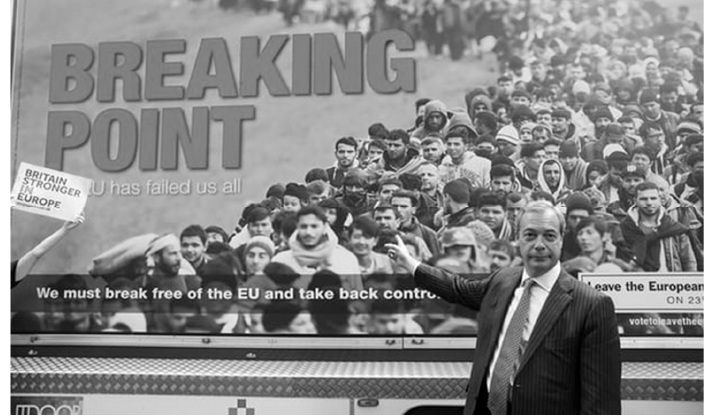
Figure 1. British politician Nigel Farage unveiling a racist poster during the Brexit campaign. (Stewart and Mason